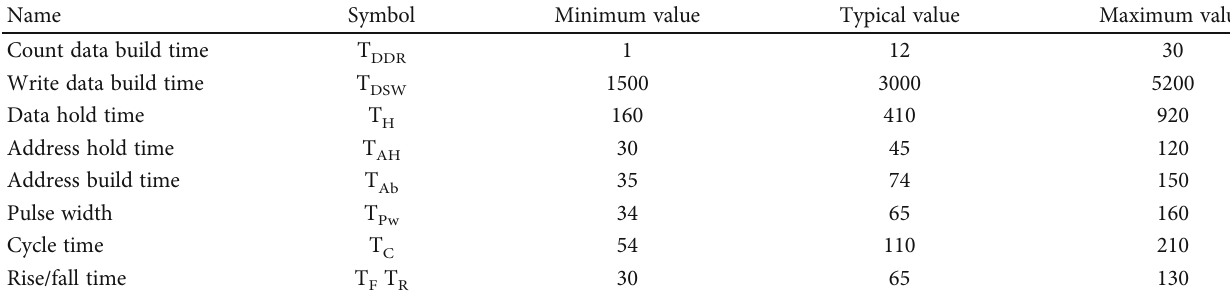
Table 1: Read and write